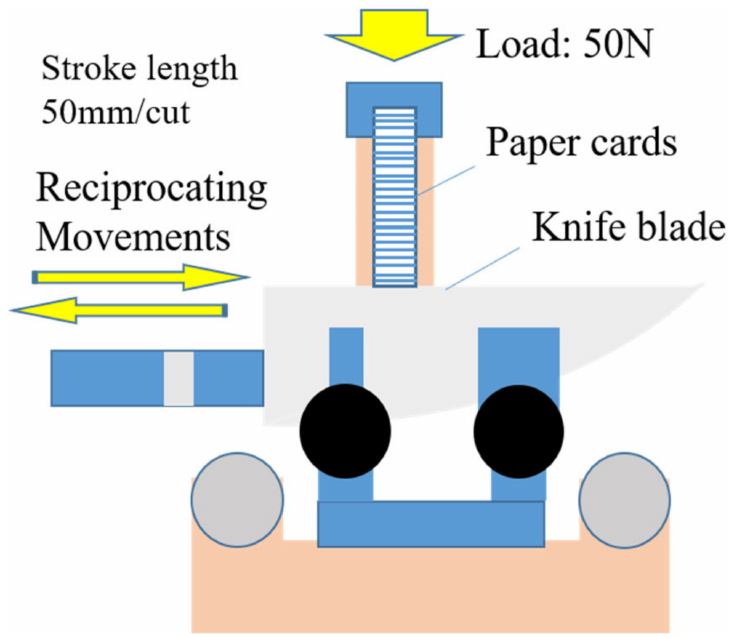
Figure 3. Schematic diagram of testing machine for the blade sharpness evaluation.